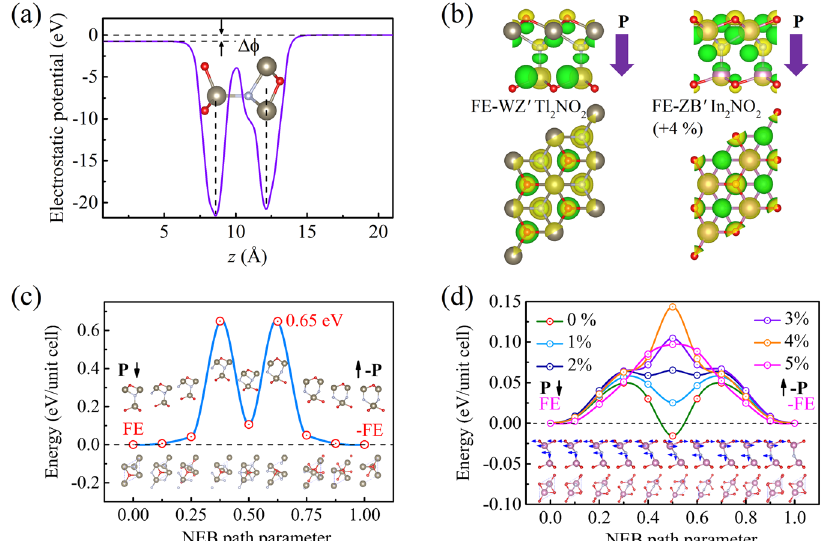
Fig. 3 Ferroelectric properties. a Electrostatic potential curve of the relaxed monolayers along the z -direction. The electrostatic potential difference ( Δ Φ ) is de fi ned as the vacuum level difference between the top and bottom surfaces. b Top and side views of charge density differences between FE-WZ ′ and fcc Tl 2 NO 2 (left), and between FE-ZB ′ and fcc In 2 NO 2 (right). Green, yellow, and violet colors denote depleted charge, accumulated charge, and electric polarization, respectively. The isovalue is 1 electron per Å 3 . c The minimum energy pathway in the polarization reversal process for FE-WZ ′ Tl 2 NO 2 monolayer. d Minimum energy pathway as a function of the in-plane biaxial tensile strain (from 0% to 5%) in the structural transition between two states with opposite electric polarization ( P and − P ) for the FE-ZB ′ In 2 NO 2 monolayer. The transformation proceeds through a centrosymmetric structure in which the polarization is zero.